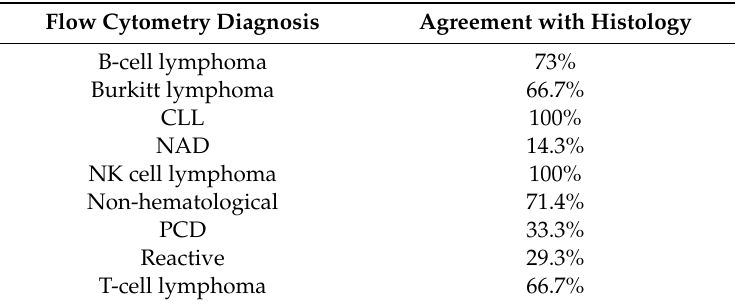
Table 2. Comparison between flow cytometry and histology diagnosis.